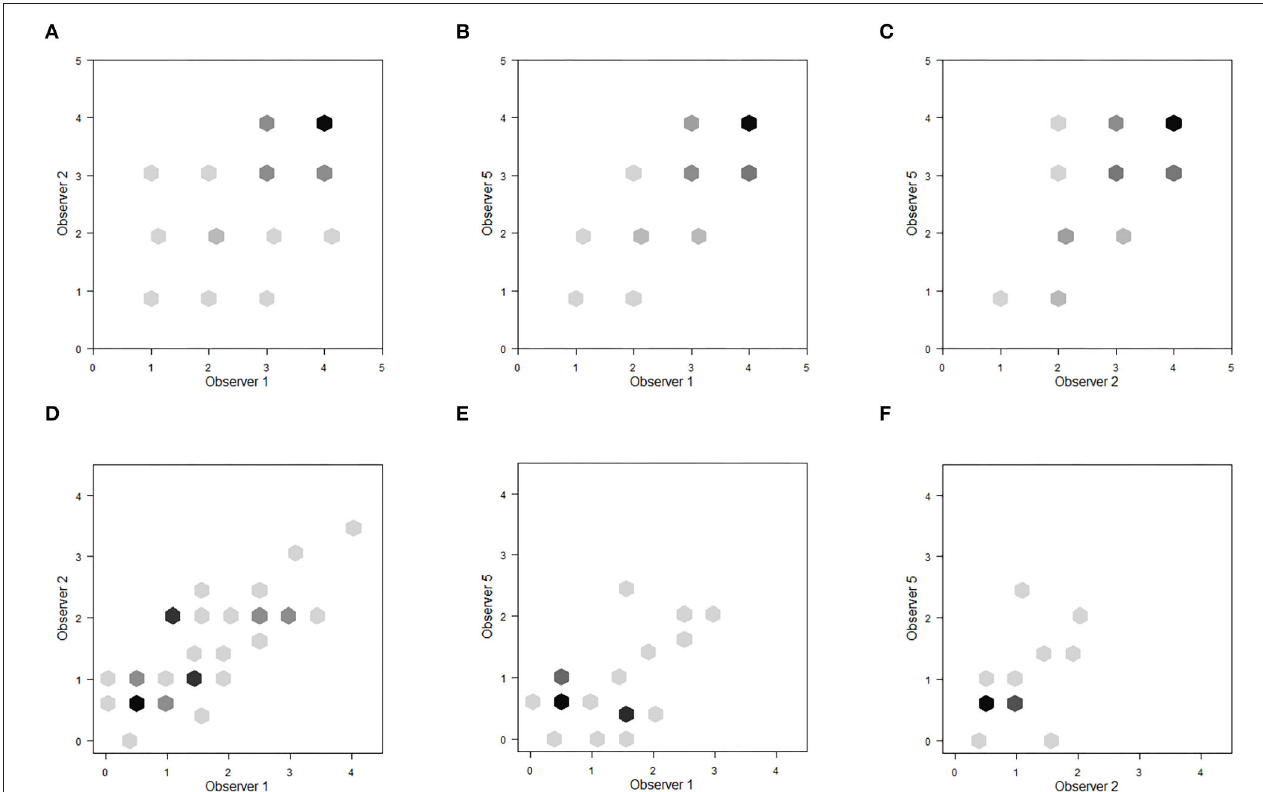
FIGURE 4 | Inter-observer reliability–Score accordance of (A,D) observers 1 and 2; (B,E) observers 1 and 5; (C,F) observers 2 and 5. (A–C) Show the plumage scores points for each body part (a: 300 scores, all other 162 scores); (D–F) show the fat scores (d: 50 scores, all other 27 scores). Darker points represent overlapping scores, the darker the more overlapping data